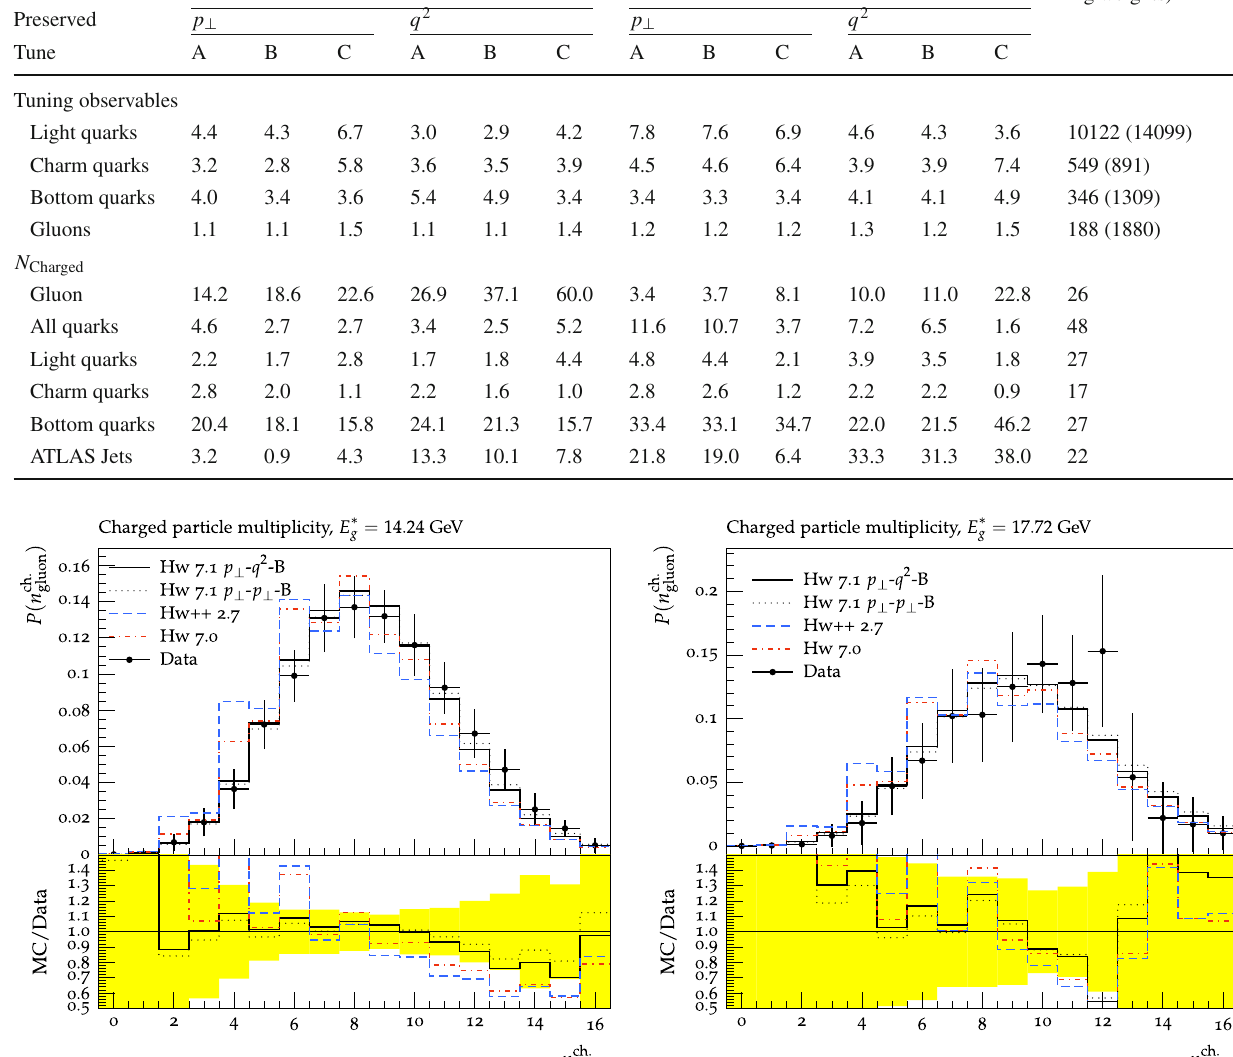
the sum of the weights for the different bins, and the true χ 2 using the experimental error for the charged particle multiplicities. The number of degrees of freedom for each set of observables is given together with the sum including weights in brackets, where this is different Virtual Mass Numberofdegreesof freedom(suminclud- ing weights)